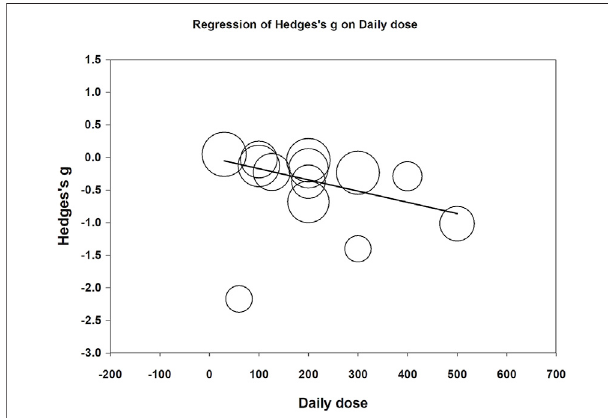
FIGURE 8 | Meta-regression of Hedges ’ g on treatment duration (day). The coef fi cient was -0.0042 with a p value of